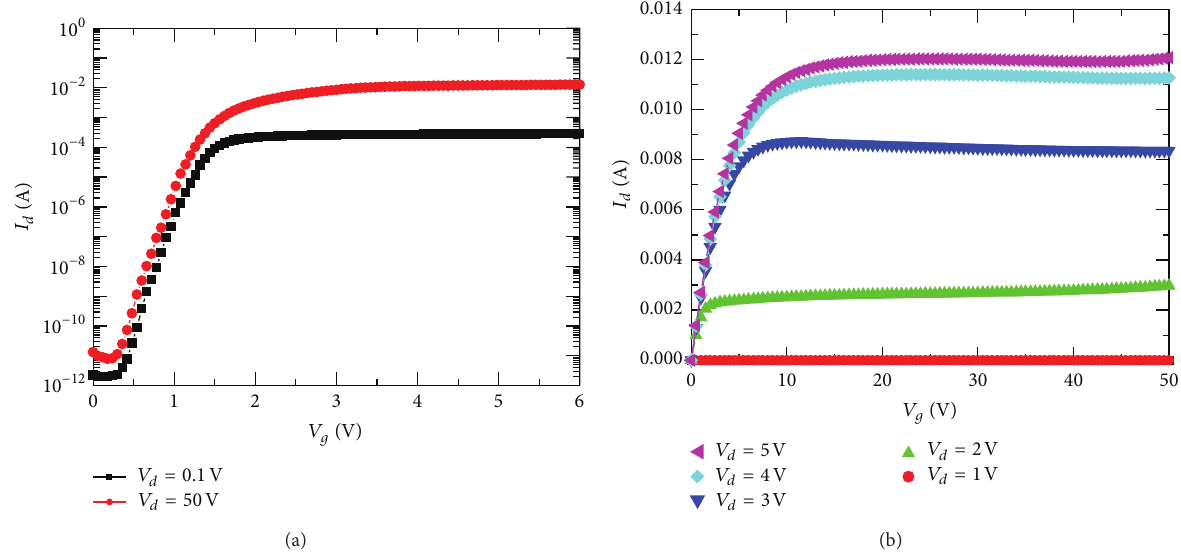
Figure 8: Optimized device characteristics (a) 𝐼 𝑑 - 𝑉 𝑔 curve and (2) 𝐼 𝑑 - 𝑉 𝑑 curve.